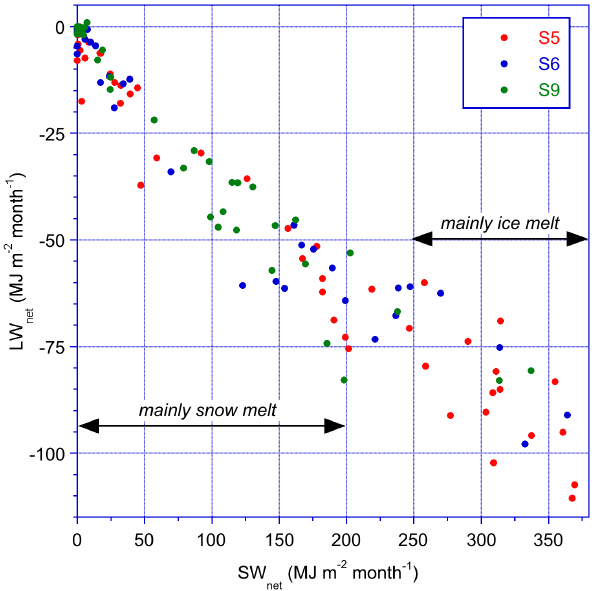
Fig. 10. Correlation of monthly mean net longwave and net short- wave radiation during melt for S5 (red dots), S6 (blue dots) and S9 (green